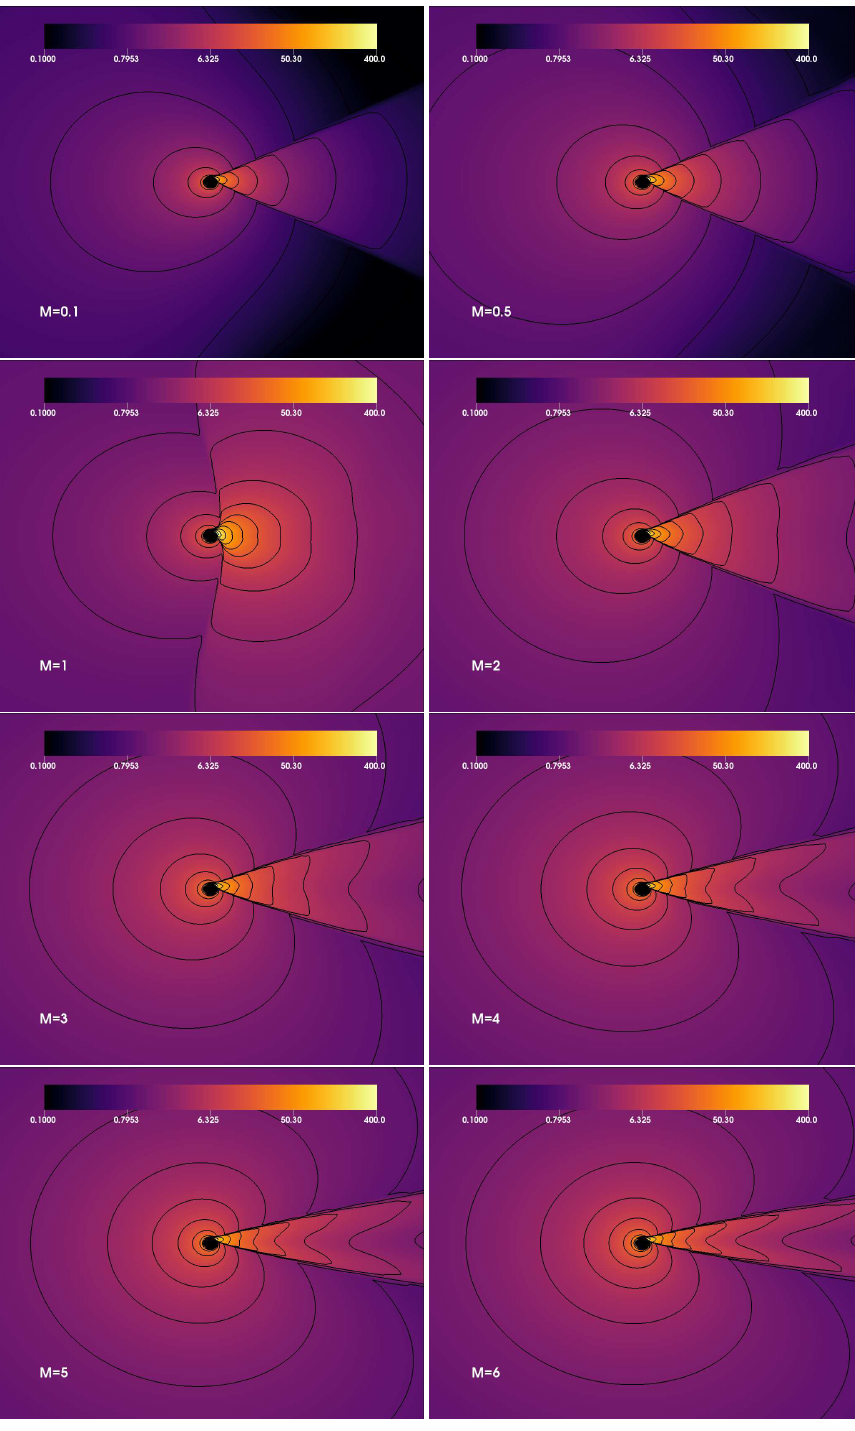
< 1 ), sonic flow ( M = 1 ), and supersonic flow ( M > 1 ). The logarithm of the Figure 1. BHL accretion from the subsonic flow ( M Figure 1. BHL accretion from the subsonic flow ( M ∞ < 1), sonic flow ( M ∞ = 1), and supersonic ∞ ∞ ∞ ) given in left bottom corner of each plot for model α = 0 . 5912 on the equatorial plane rest-mass density for asymptotic Mach number ( M flow ( M ∞ > 1). The logarithm of the rest-mass density for asymptotic Mach number ( M ∞ ) given in − ∞ φ ). The opening angle of the shock cone decreases with the increasing M ( r in the supersonic flow. − ∞ φ ). The opening bottom-left corner of each plot for model α = 0.5912 on the equatorial plane ( r − − angle of the shock cone decreases with the increasing M ∞ in the supersonic